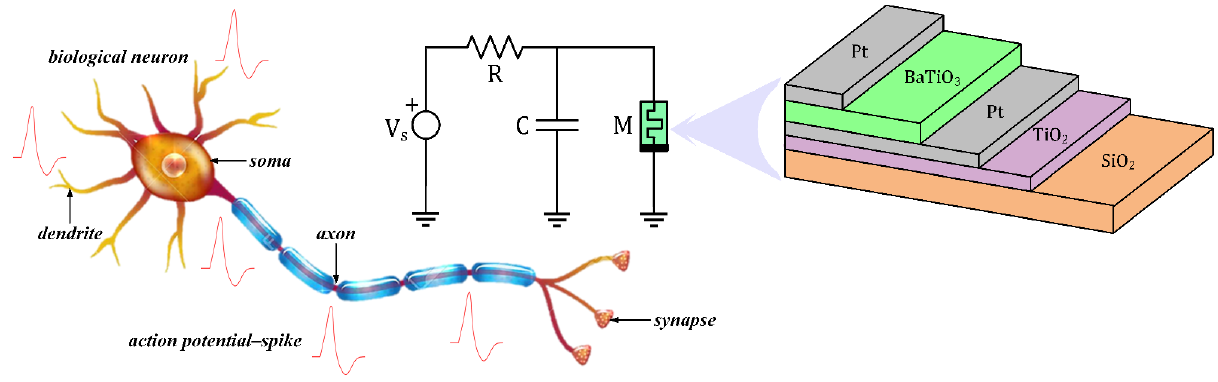
Figure 2. Memristive leaky integrate–and–fire artificial neuron and biological neuron counterpart. Results of the SPICE simulations of LIF neuron with volatile memristor are given in Figure 3, parameters values were implemented from [23], while external components equal to: neuron resistance is R = 10 Ω k and membrane capacitance is initially set to C = 50 nF and later variated demonstrating their influence on neuron dynamics. SPICE code (LTspice version) used for simulation of the volatile memristor is included in Appendix A. Values of memristor’s subcircuit model parameters are given in Table 2, while inde- pendent and controlled source values follow from the model’s equation [23]. Table 2. Memristor’s subcircuit model